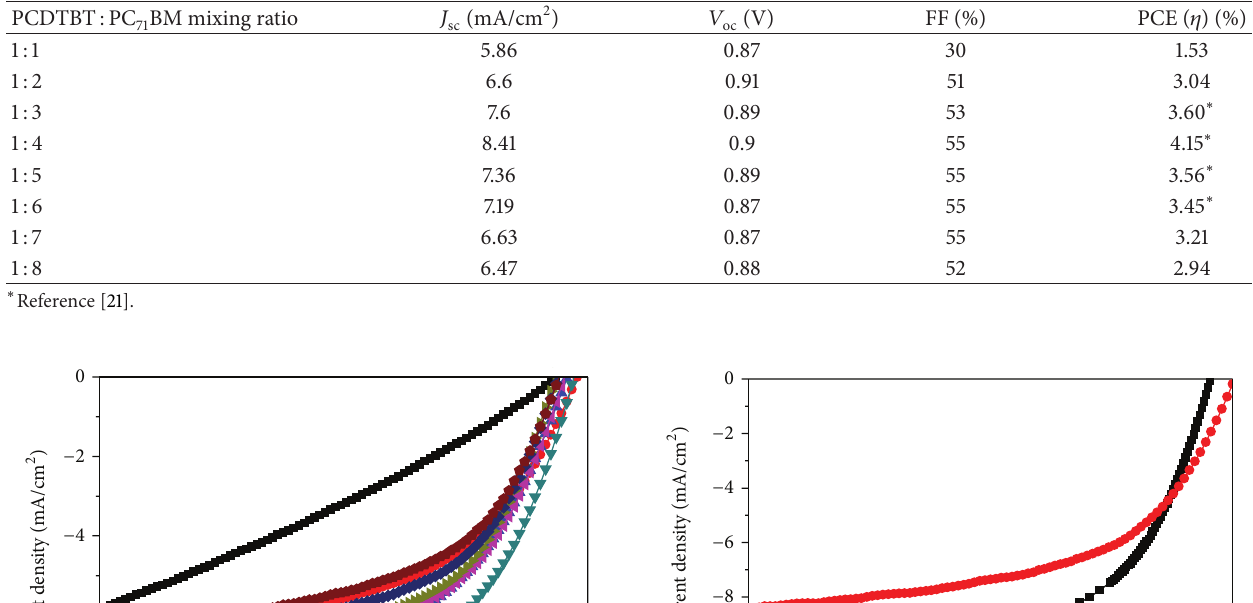
BM prepared with different mixing ratios 1: 1 ∼ 1:8 in o-DCB. 71